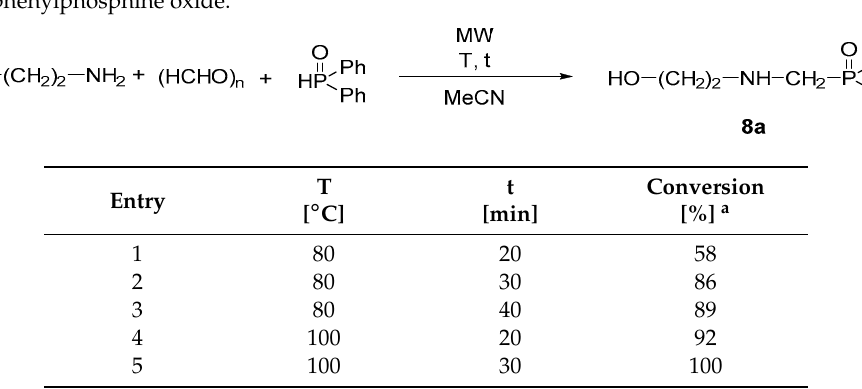
Table 3. Optimization of the condensation of ethanolamine, paraformaldehyde, and diphenylphosphine oxide.